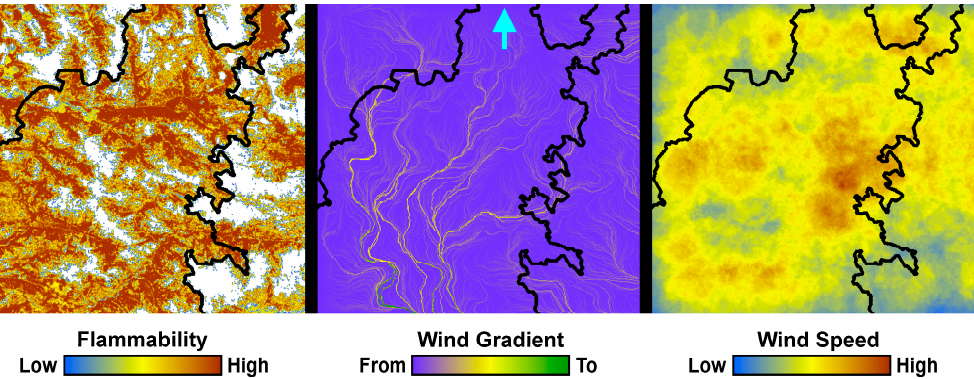
Figure 3. Example 2 spatial inputs, including relative flammability ( left ), wind gradient ( center ) and relative wind speed ( right ). The emergent simulated burn perimeter (see Results) is shown as a black outline. The arrow at the top-center indicates the location at which the fire was initiated.